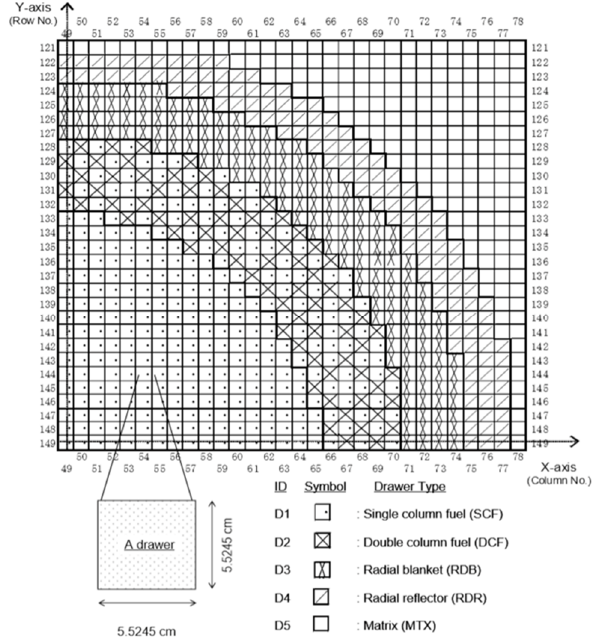
Figure 4. Specifications of ZPPR-9 core.